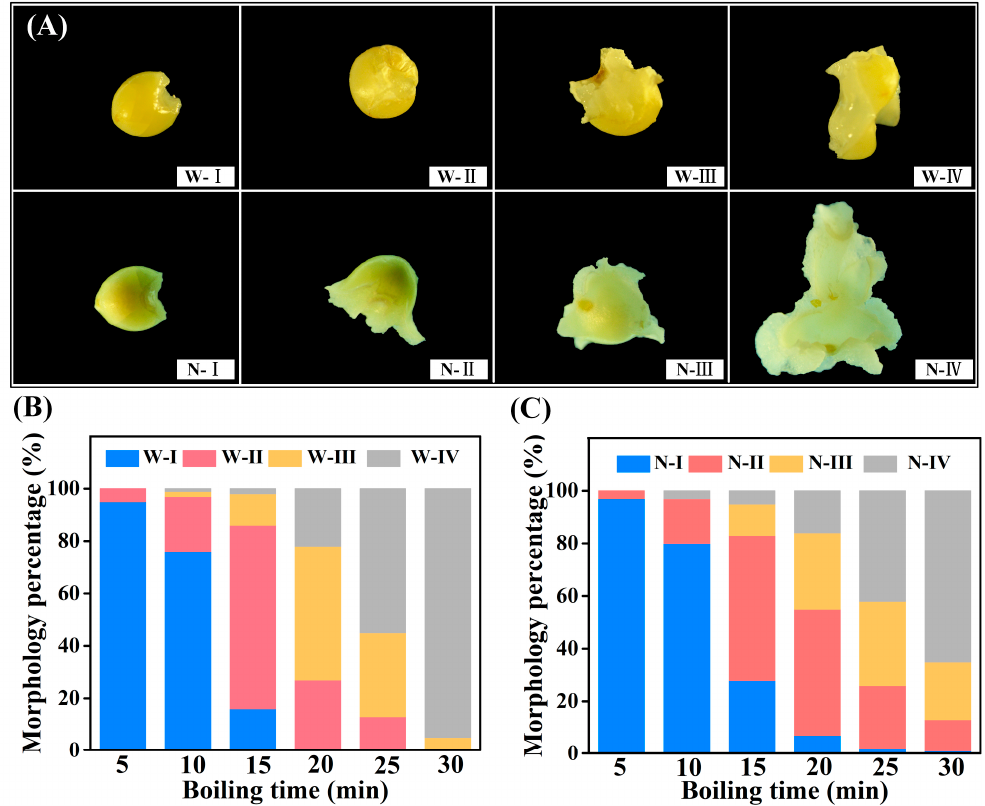
Figure 2. Representative morphologies of cooked proso millet grains ( A ) and the percentage of the morphological types of waxy ( B ) and non-waxy ( C ) proso millet grains. W-I-W-IV: Four morphology types of waxy proso millet grain; N-I-N-IV: Four morphology types of non-waxy proso millet grain.